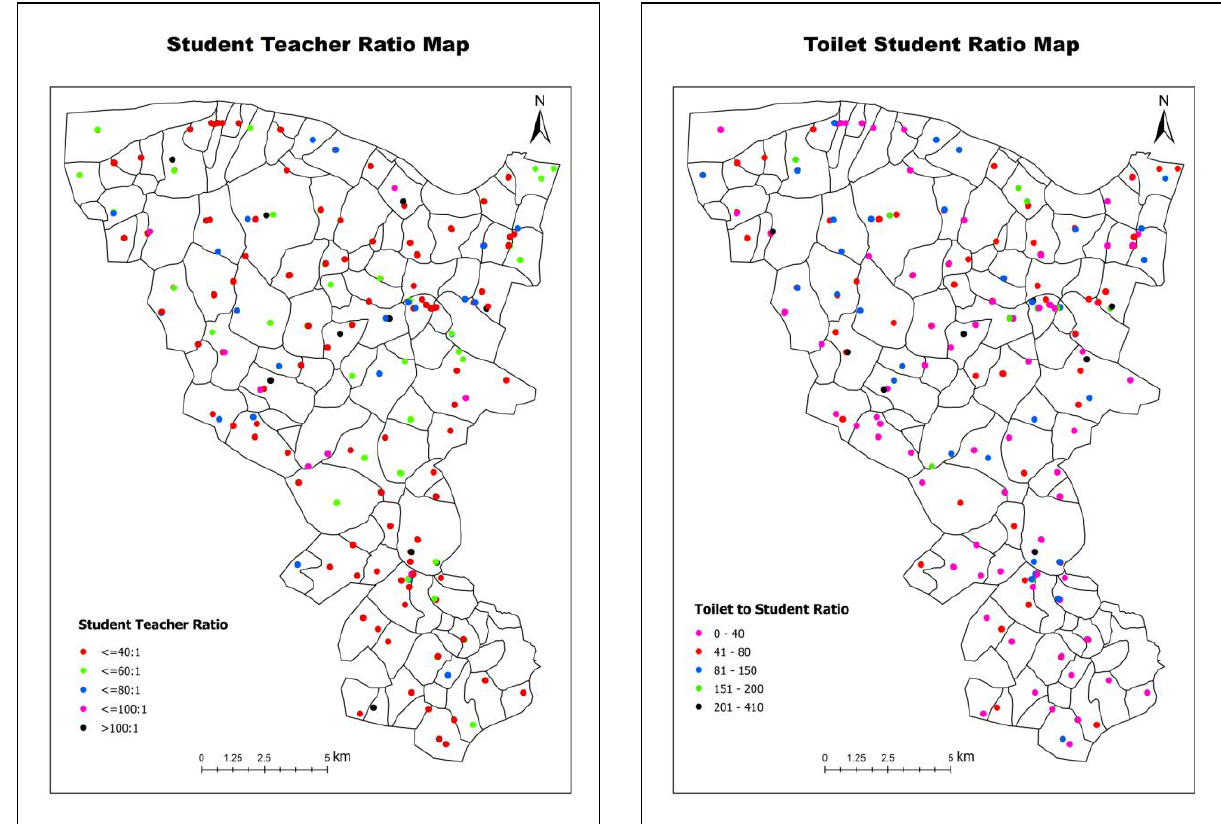
Figure 8. Map showing the toilet student ratio in